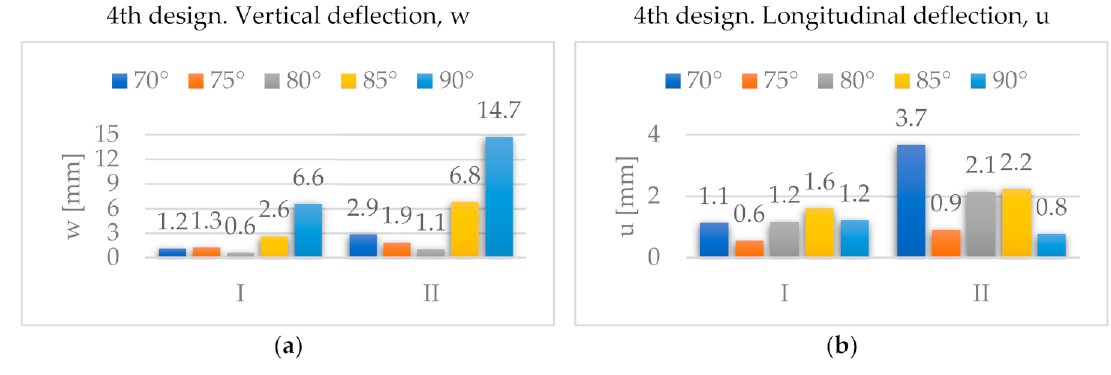
( b ) Figure 17. Evolution of maximum stresses [MPa] with α , for the 4th design: ( a ) σ xx ; ( b ) σ yy .